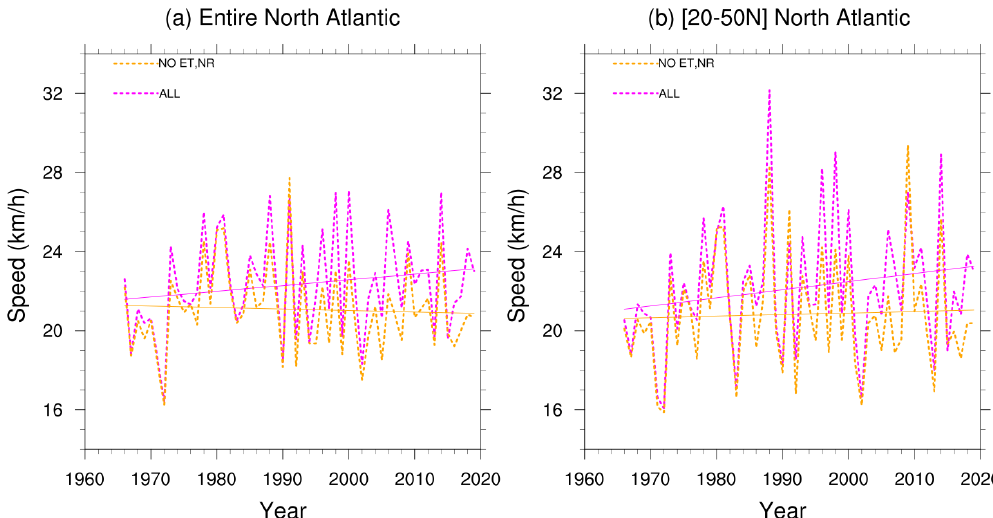
Figure 10. Annual-mean speed and linear trend for (a) the entire Atlantic and (b) 20–50 ◦ N latitude band. The magenta curve is for all storms in the IBTrACS dataset, while the orange curve excludes instances when the storm was classified as ET or